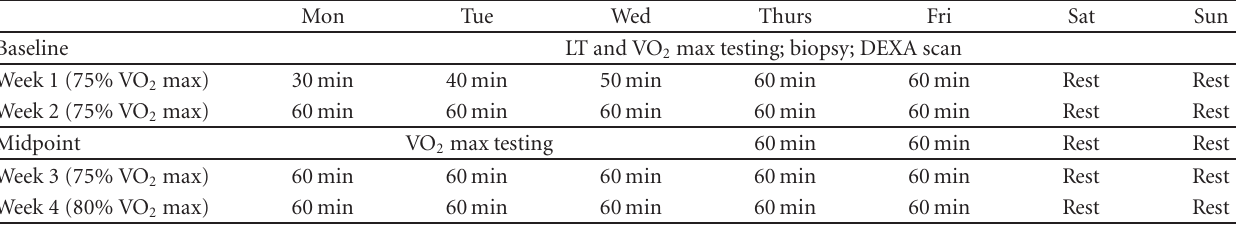
Table 2: Protocol for training period.